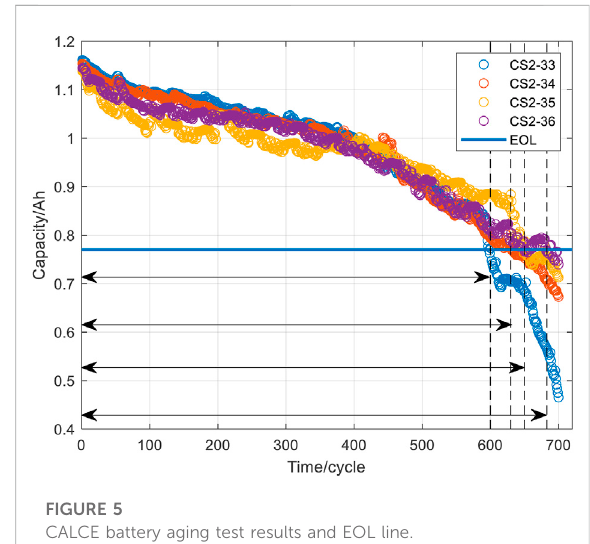
FIGURE 5 CALCE battery aging test results and EOL